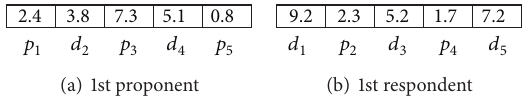
Figure 1: Representation of